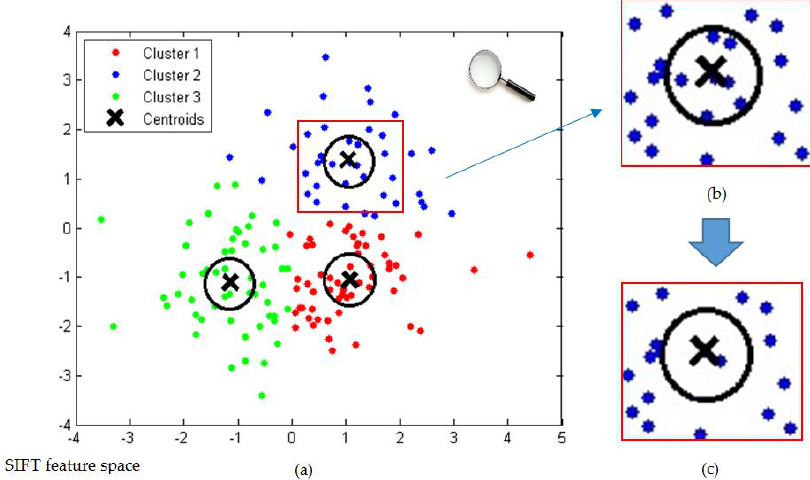
Figure 5. Central idea of removing keypoints ( a ) Clustered keypoints with “k-means” in SIFT feature space. ( b ) Original keypoints in one cluster ( c ) Selected keypoints with a distance threshold.